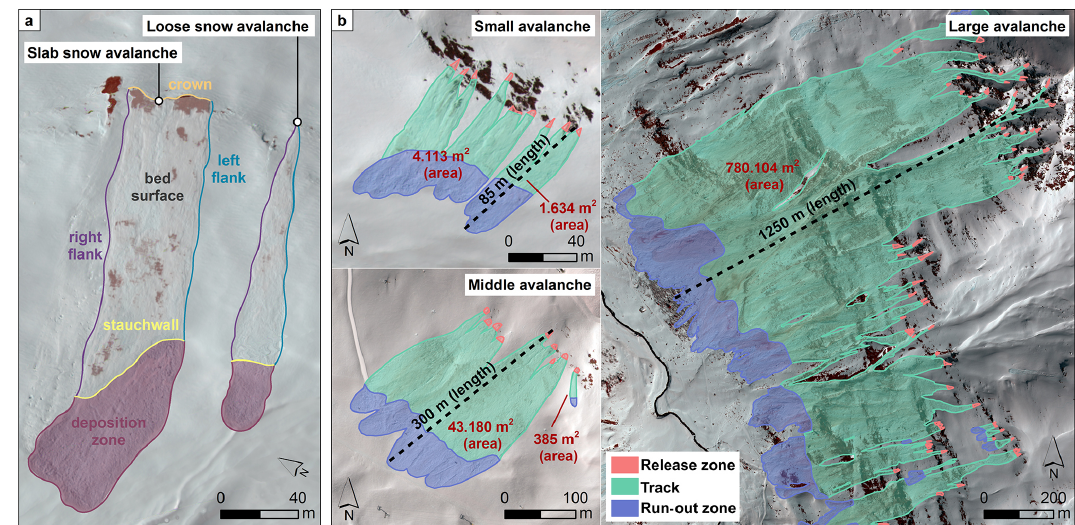
Figure 2. (a) Types of avalanche release: slab avalanches and loose avalanches, with marked avalanche parts (crown, bed surface, stauchwall, deposition zone, and right and left flanks; Schweizer et al., 2003); (b) avalanche classification with respect to length (small, middle, and large, in metres), with the avalanche area (m − 2 ) and marked parts of avalanches (release zone, track, and run-out zone). Data from WSL Institute for Snow and Avalanche Research SLF, Davos,